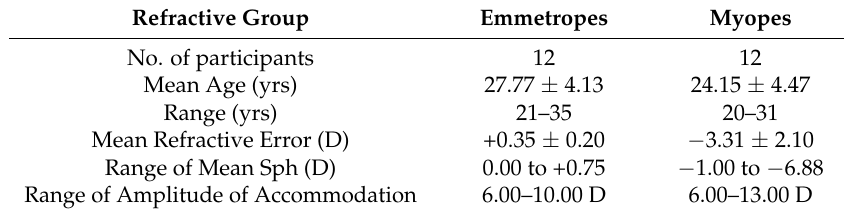
Table 1. Information regarding participants in the experiment. ± values refer to one standard deviation of the